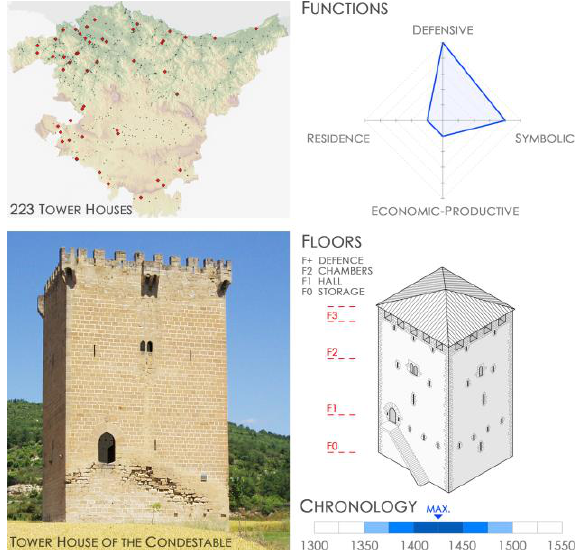
Figure 2. The Tower Houses of the Basque